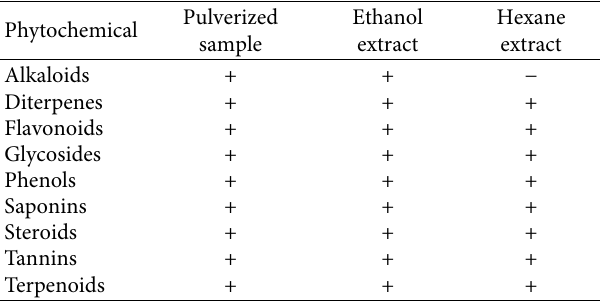
Key. + � presence of secondary metabolite; − � absence of secondary